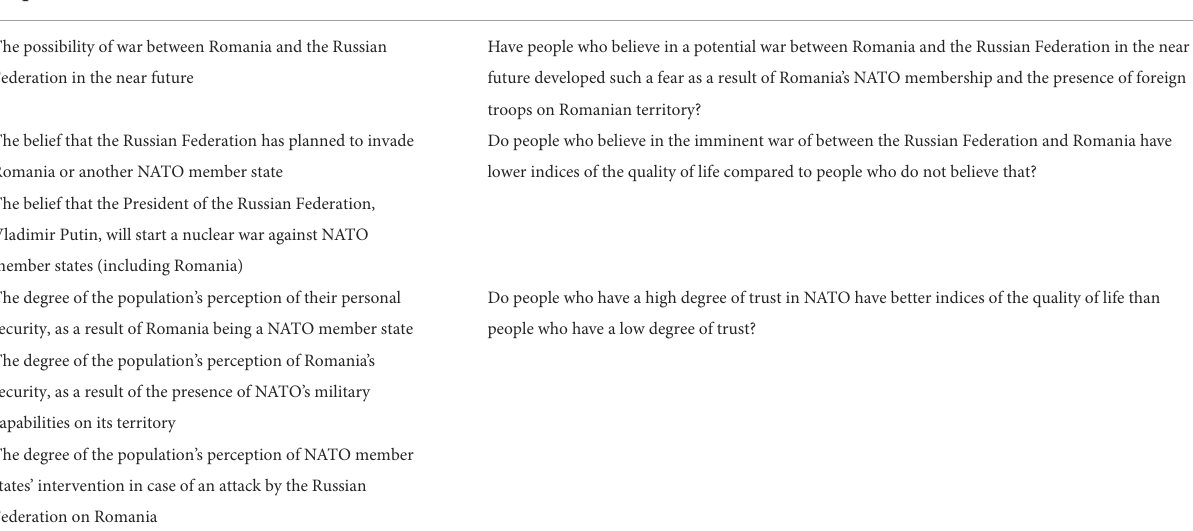
TABLE 1 Required data and research questions.